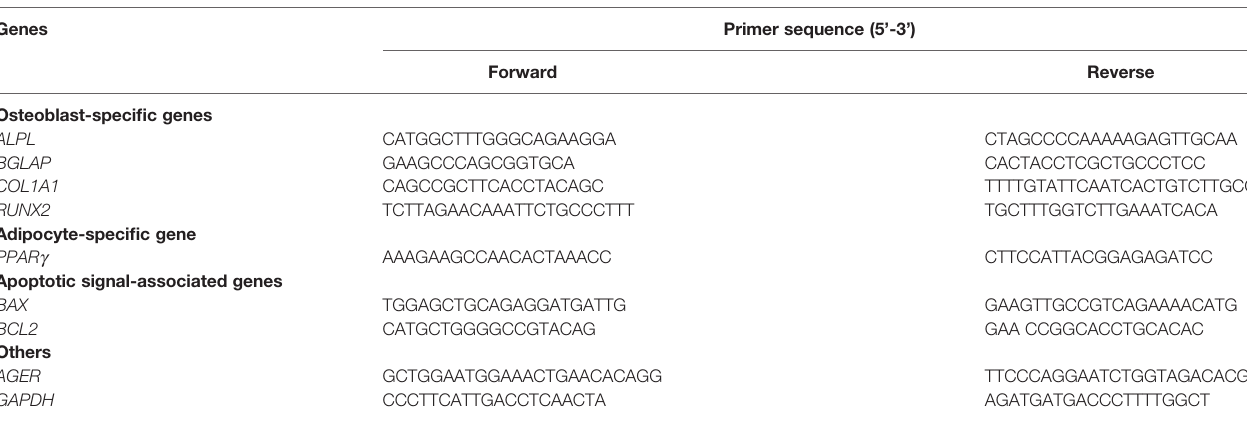
TABLE 1 | Sequences of Real-Time qPCR Primers.